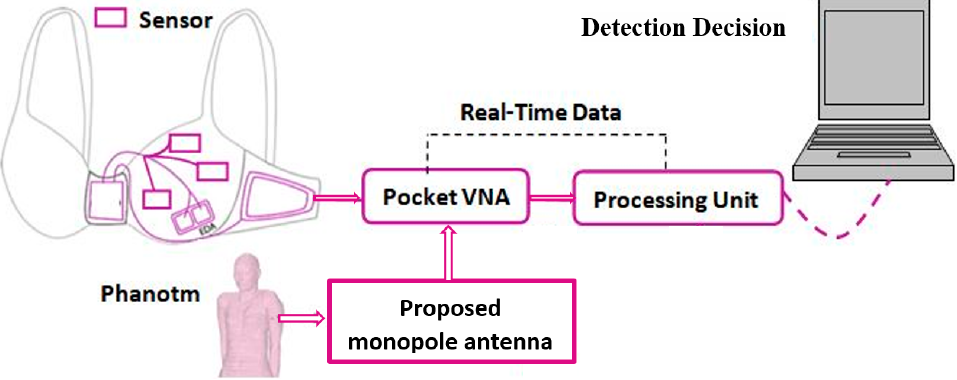
Figure 1. The proposed breast cancer detection system as a “Smart Bra”.